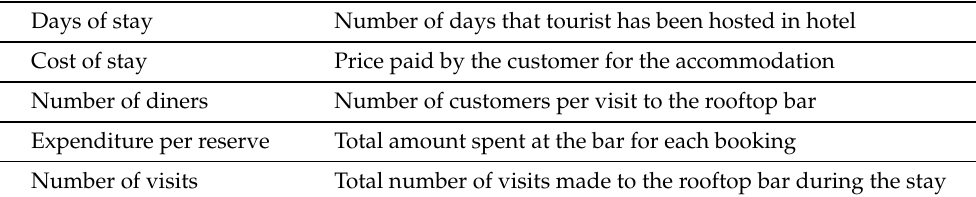
Table 1. Description of variables that are incorporated into the model. Days of stay Number of days that tourist has been hosted in hotel Cost of stay Price paid by the customer for the accommodation Number of diners Number of customers per visit to the rooftop bar Expenditure per reserve Total amount spent at the bar for each booking Number of visits Total number of visits made to the rooftop bar during the stay Source: own